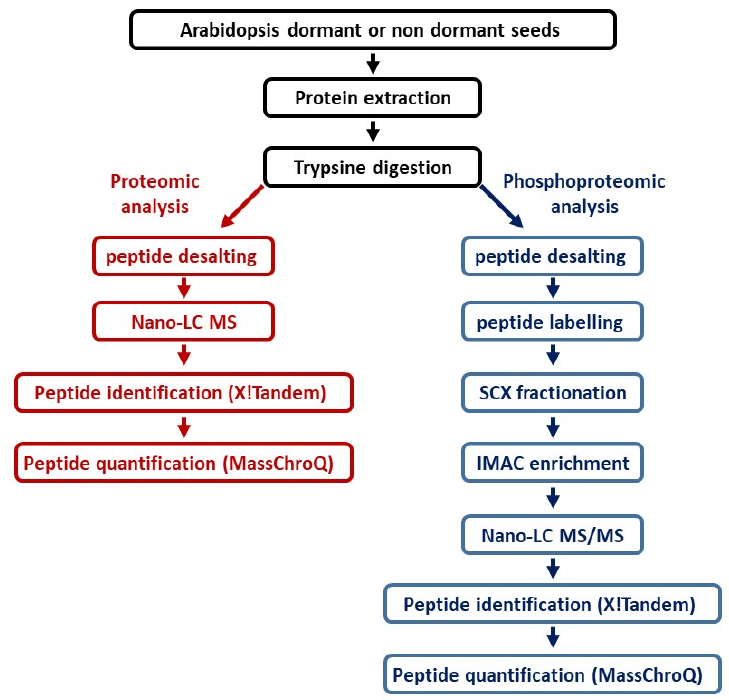
Figure 2. Overview of the workflow for seed protein and phosphoprotein identification.